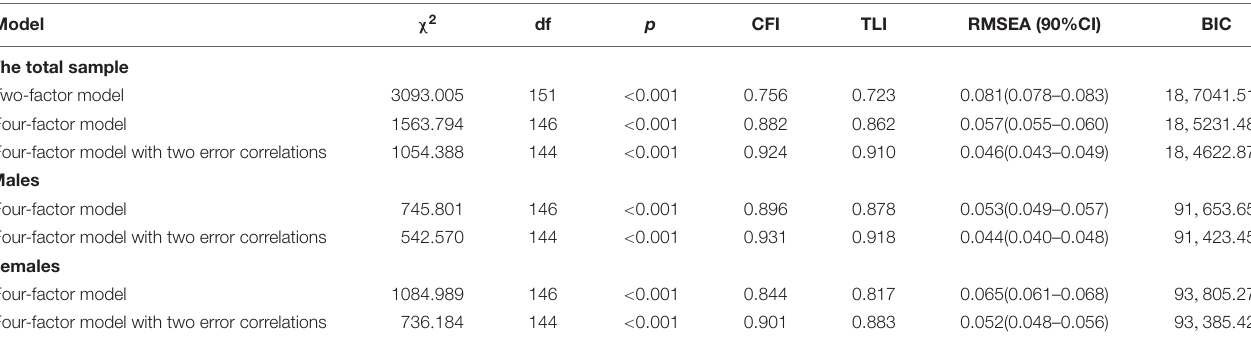
TABLE 6 | Goodness-of-fit indices for each model in total sample and sub group. Model